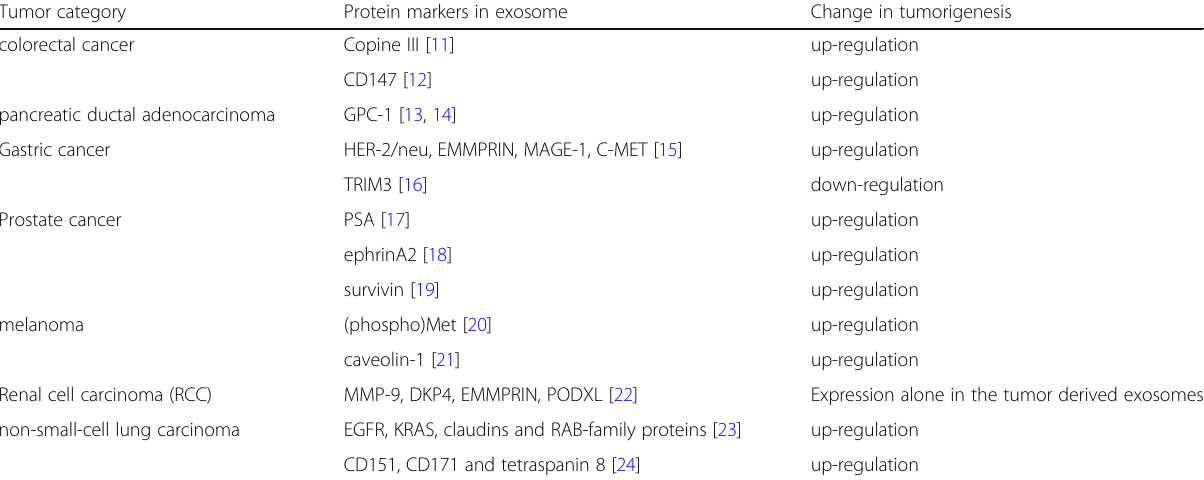
non-small-cell lung